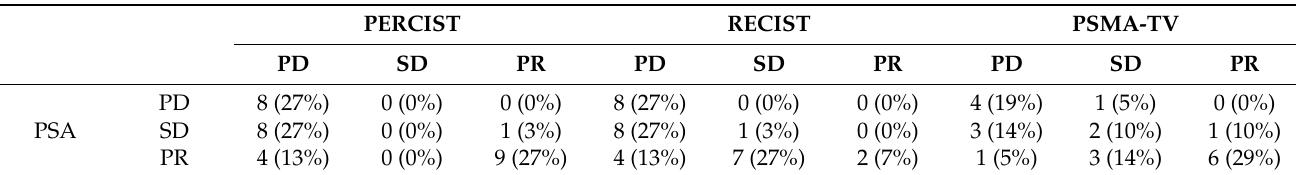
Table 3. Results of biochemical response assessment and image response assessment evaluated using PERCIST criteria in PET and RECIST criteria in CT in 30 patients.